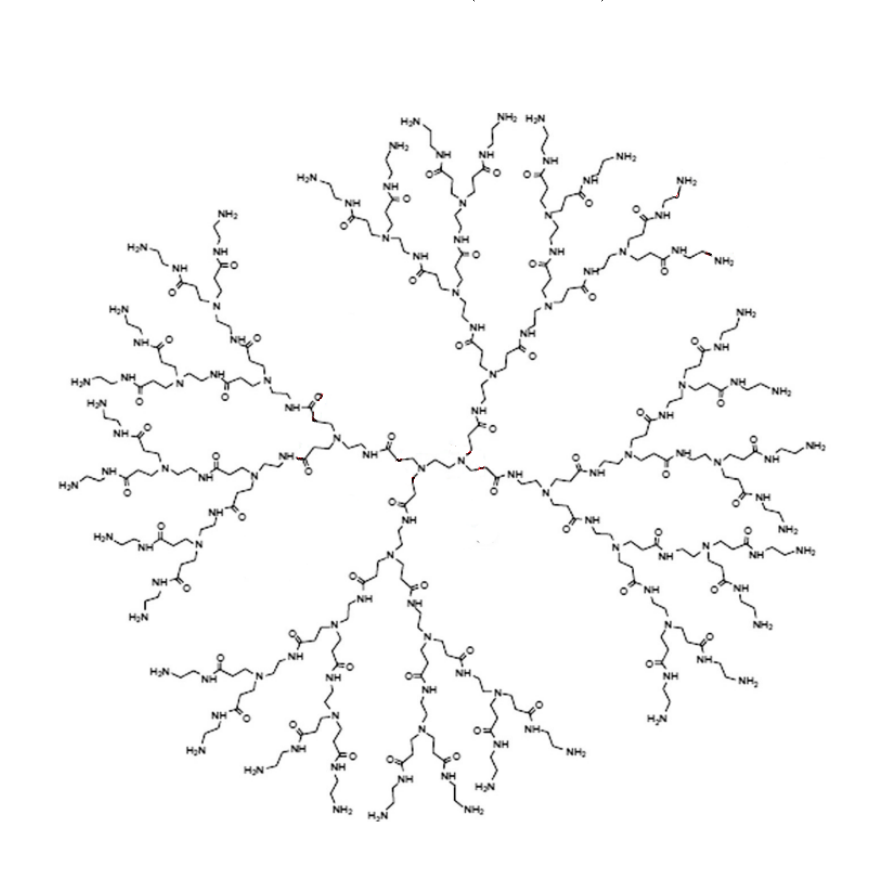
Figure 1. D 1 ( n ) with n = 3.